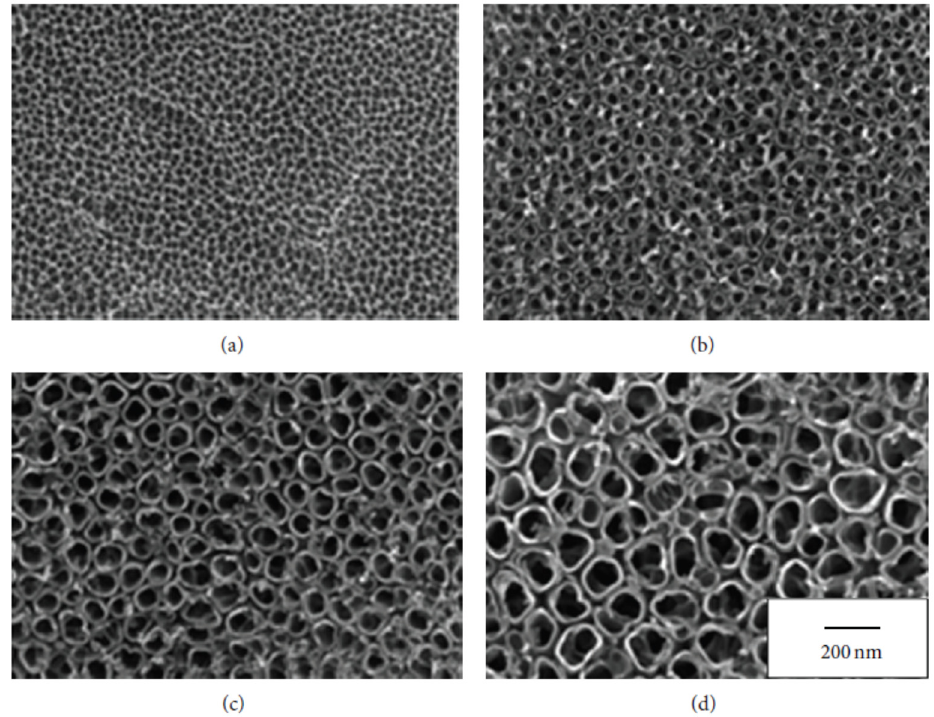
Figure 1. SEM images of different diameter sizes of TiO 2 nanotubes, ( a ) 30; ( b ) 50; ( c ) 70 and ( d ) 100 nm using 200 nm scale bar. Adapted from Ref.